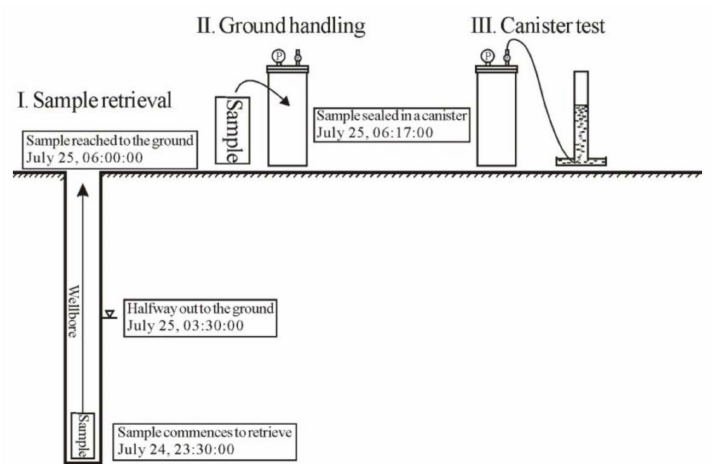
Figure 3. Shale core sampling procedure for canister testing in the field (the real times related to the canister test used in this study are noted in